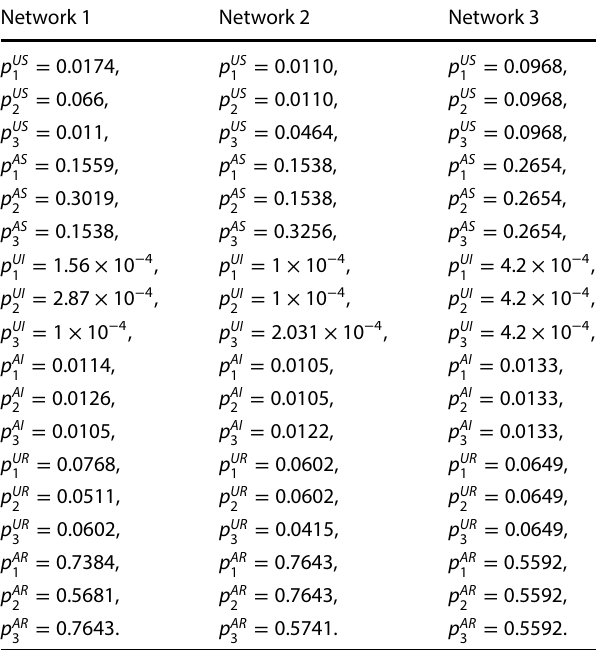
Table 1 Steady state probability values for MMCA networks Network